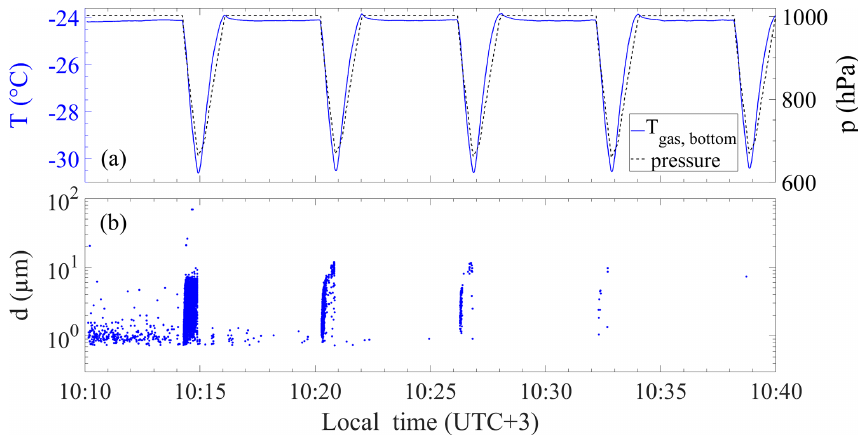
Figure A3. Background test run showing that after four consecutive expansion runs the total particle count is almost zero (only one droplet count detected in expansion no. 5).